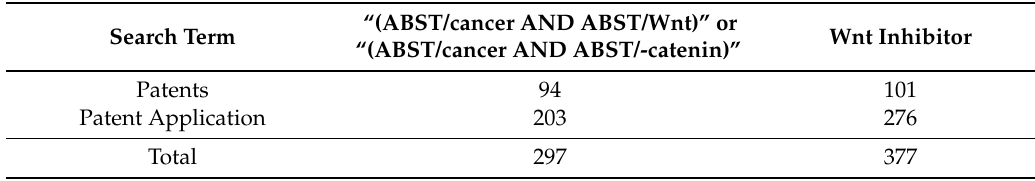
Table 1. General search results of the USPTO patent and patent application databases. “(ABST/cancer AND ABST/Wnt)” Search Term